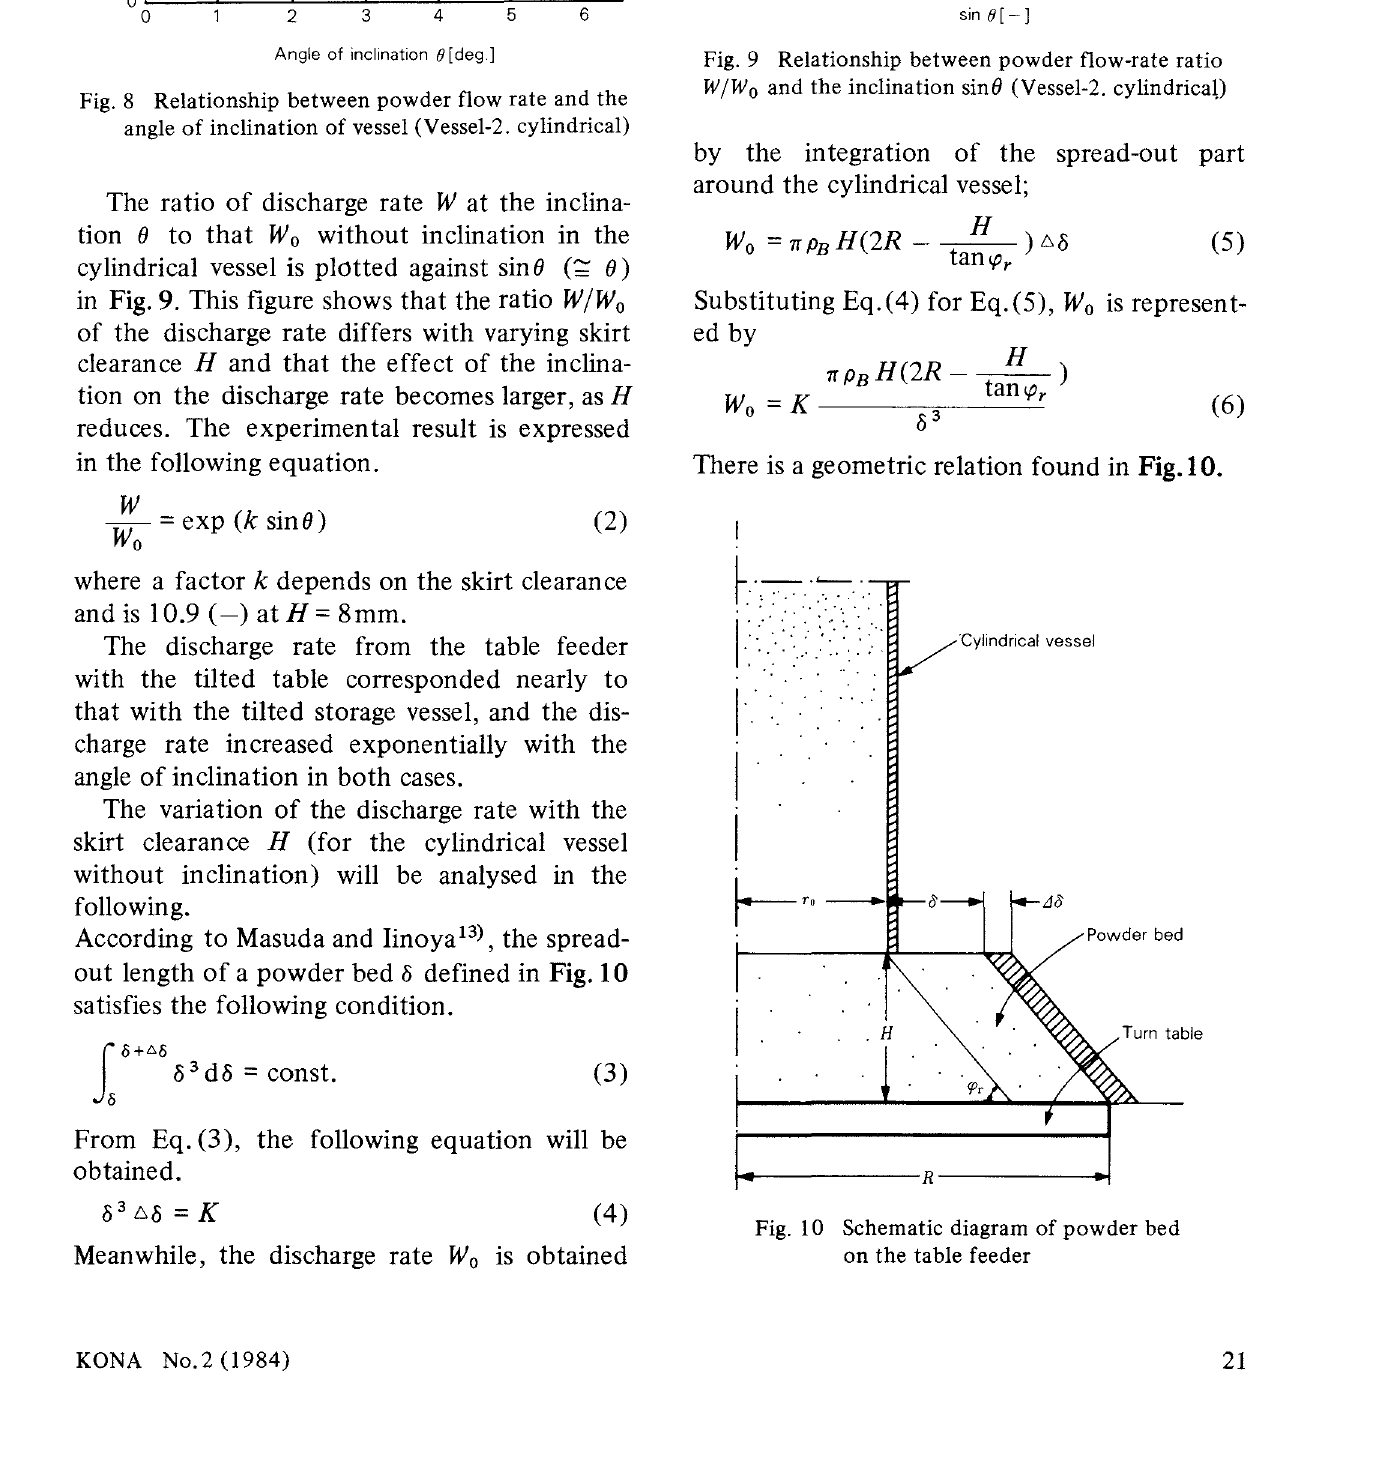
Fig. 9 Relationship between powder flow-rate ratio WjW 0 and the inclination sin() (Vessel-2. cylindrical) by the integration of the spread-out part